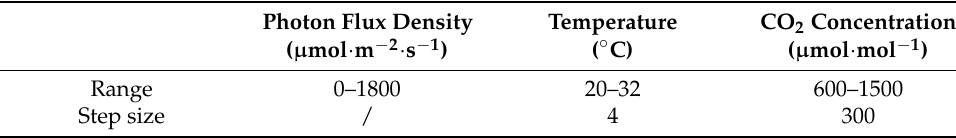
Table 1. Experimental environment parameter